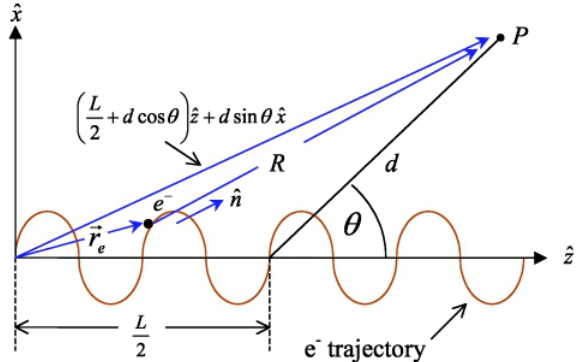
FIG. 2. (Color) Geometry for energy calculations. P is the point of observation, (cid:2) r e is the instantaneous position of the electron, R and ˆ n are the distance and direction, respectively, from the electron to the point of observation, and d is the distance from the center of the undulator to the point of